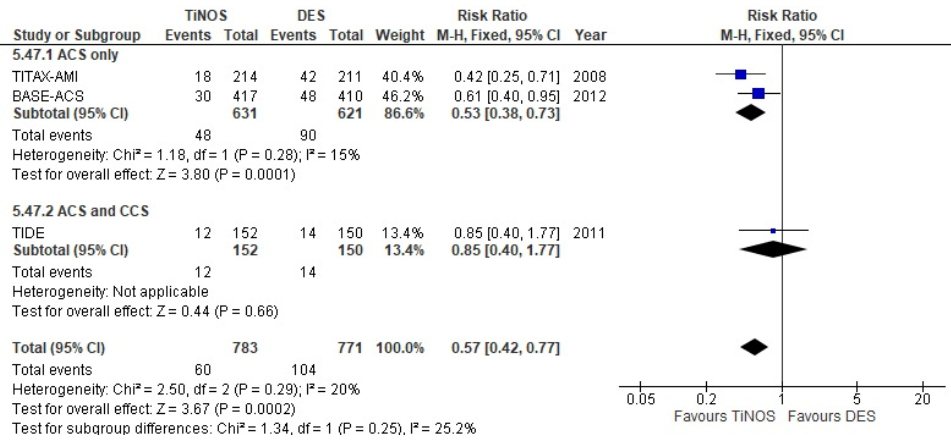
Figure 7. CD or MI—5 years.